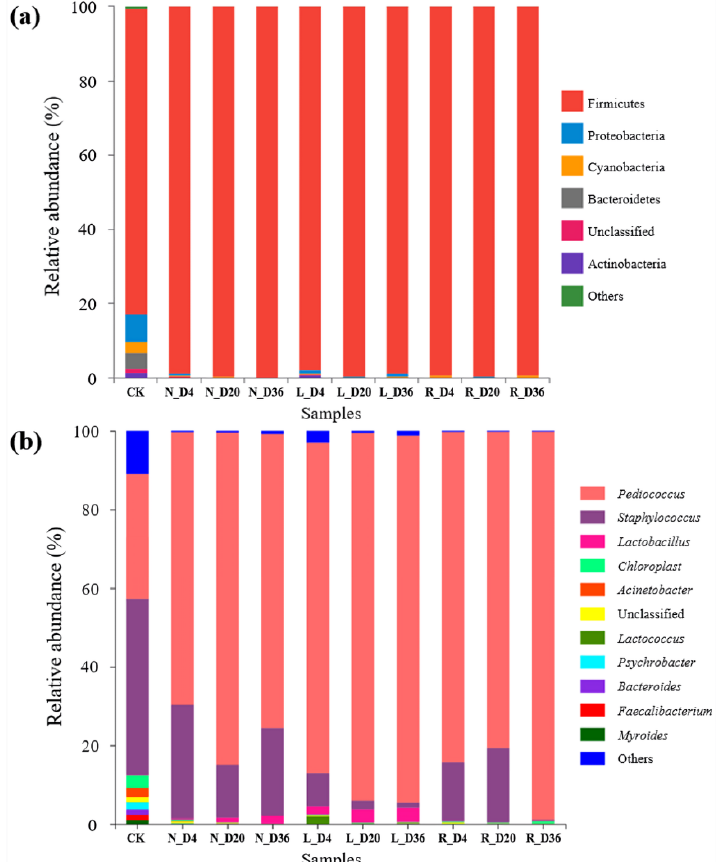
Figure 3. Relative abundance of the bacterial community based on 16S rDNA sequencing at the phylum ( a ) and genus ( b ) levels in fermented sausages. CK: initial fermented sausages (unfermented), N: fermented sausages with 3% NaCl (reference), L: fermented sausages with 2.25% NaCl (25% reduction), R: fermented sausages with partial replacement of 25% NaCl. The marks “D4, D20 and D36” represent the processing times (days).